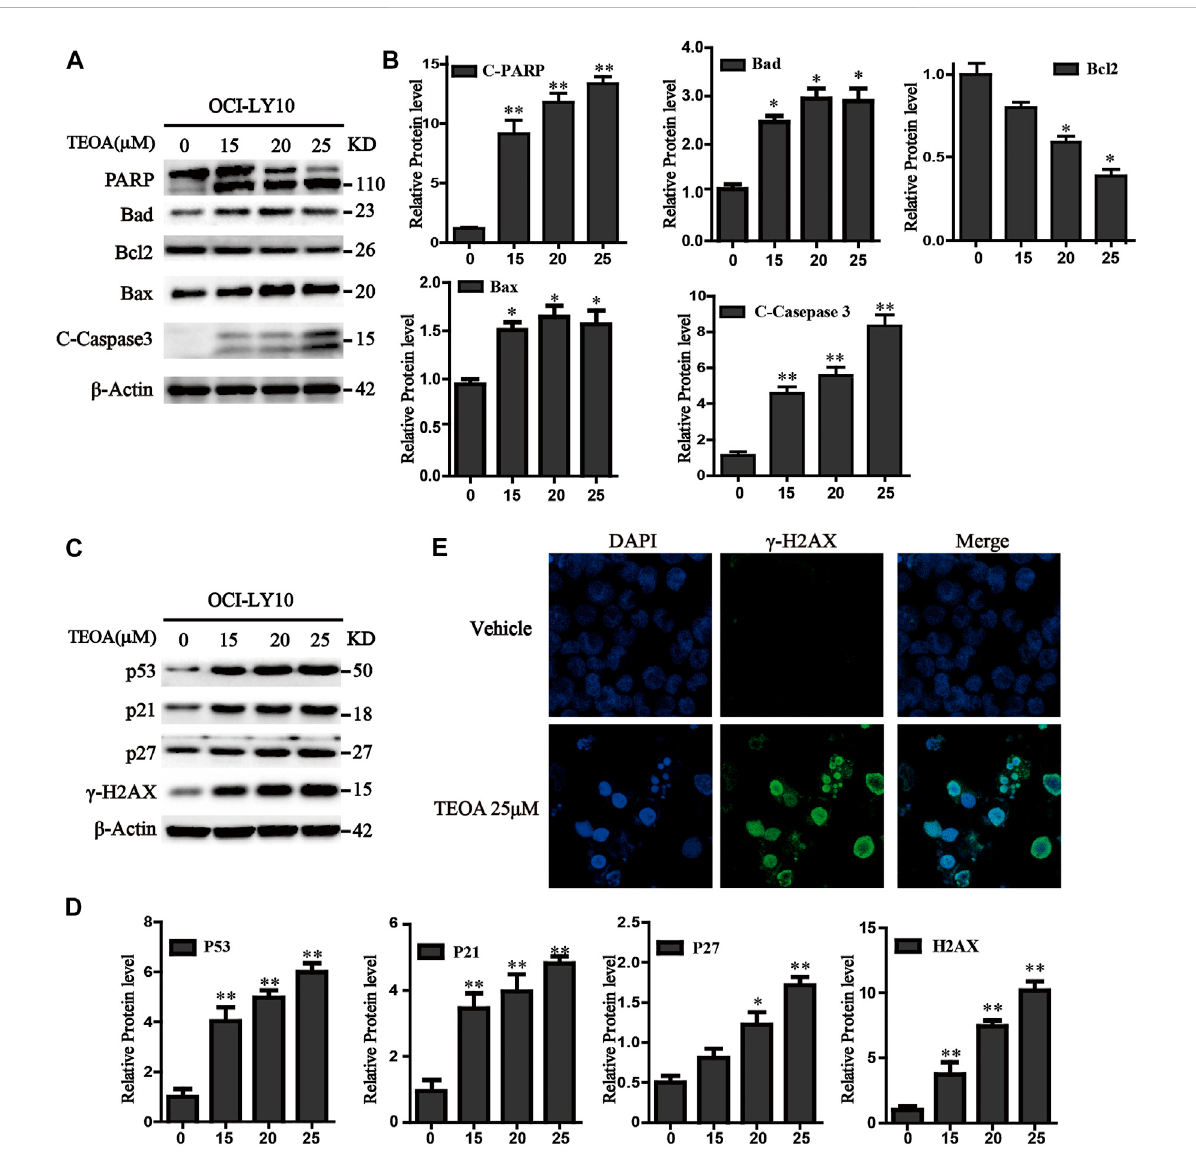
FIGURE 3 TEOA affected the expression of apoptosis-related protein in OCI-LY10 cells. (A) Diffuse large B-cell lymphoma (DLBCL) cells were exposed to various concentrationsof TEOA for 12 h.The expression ofthefollowingapoptosis-related proteins wasdeterminedby western blot: cleaved PARP, caspase-3, and Bcl-2 family members Bcl-2, Bad, and Bax; β -actin was used as a loading control. (B) The quantitation of cleaved PARP, caspase-3, Bcl-2, Bad,andBaxwereshown. p p < 0.05; pp p < 0.01. (C) OCI-LY10cells weretreatedwith differentdosesofTEOA for 12 h.The expression of P53, P21, P27, and g-H2AX protein was determined by western blot; β -actin was used as a loading control. (D) The quantitation of P53, P21, P27, and γ -H2AX.Datawerepresentedasmean±SD. p p < 0.05; pp p < 0.01. (E) OCI-LY10cellsweretreatedwith25 μ MTEOAfor12 handstainedwith γ -H (1:200) antibody. DAPI was used for nucleus staining. Images were acquired with the confocal laser scanning